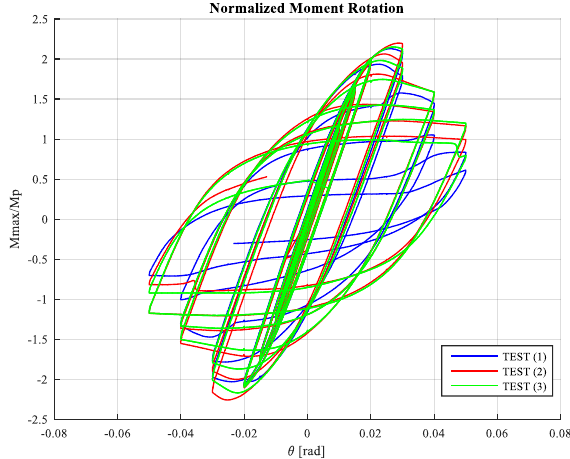
Figure 7. Comparison of normalized moment vs. rotation curve between test 1, test 2 and test 3.